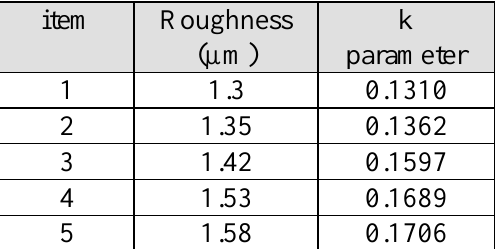
Table 3: K parameter correspond surface roughness values from fitting equations.